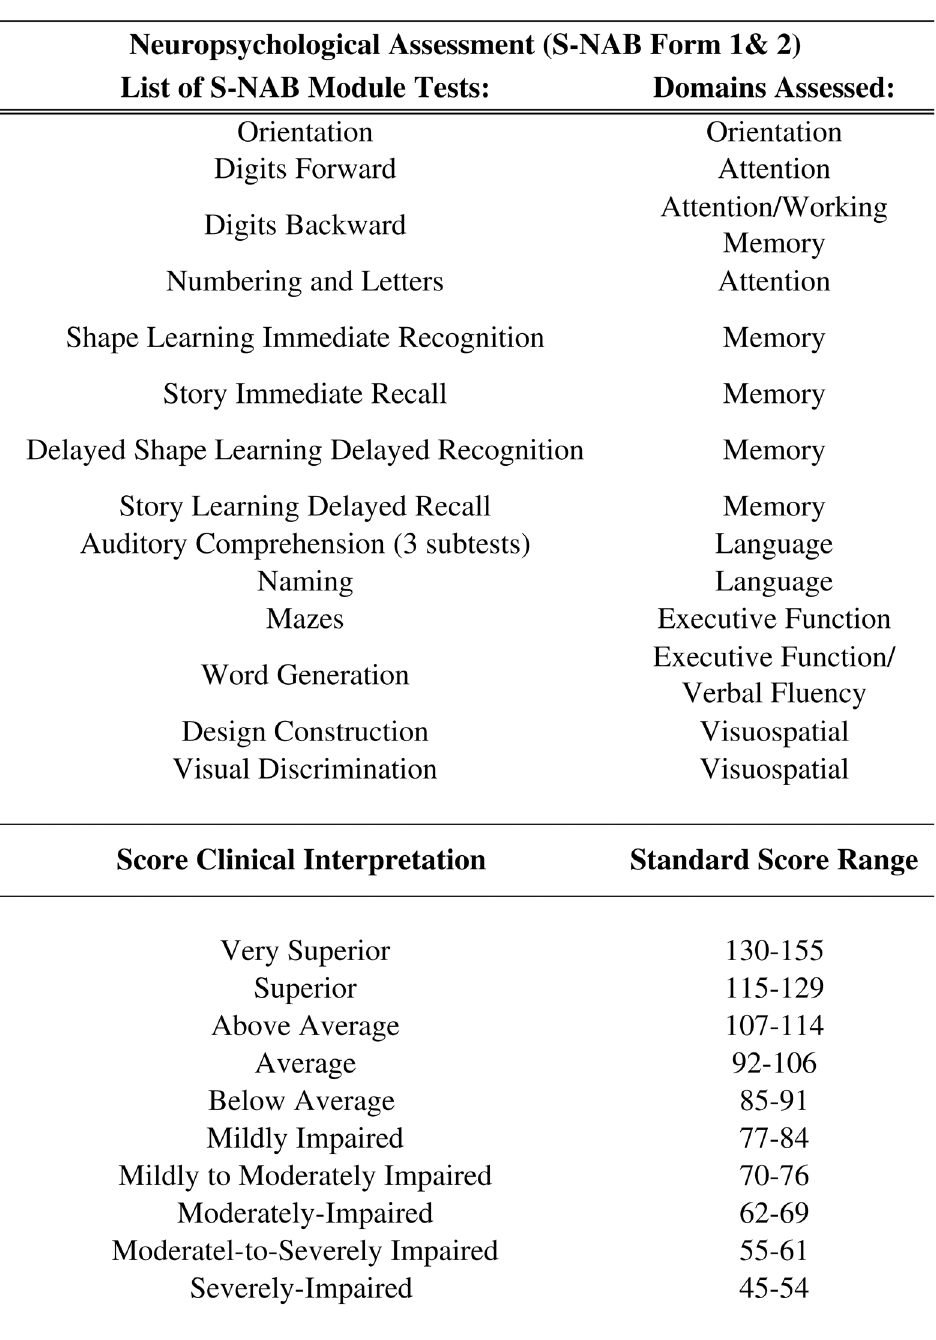
Fig 3. List S-NAB module subtests and areas of cognitive domains assessed, standard score range of individual domains in S-NAB, and clinical interpretation of the scores.